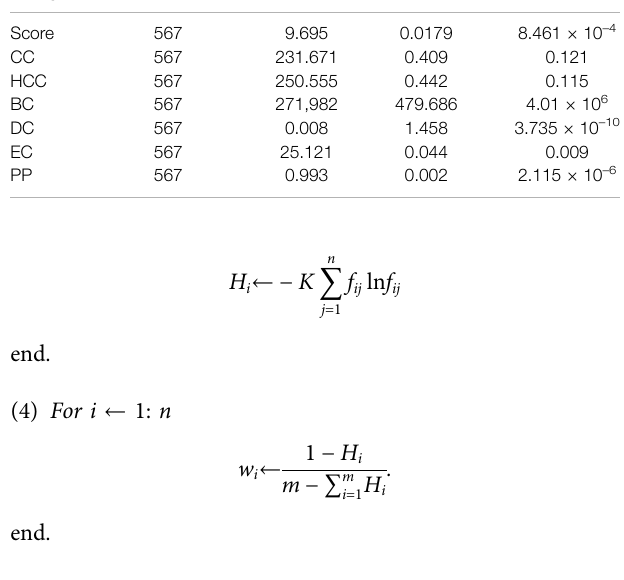
TABLE 4 | Statistical description of the results of traditional methods and our ways. Group